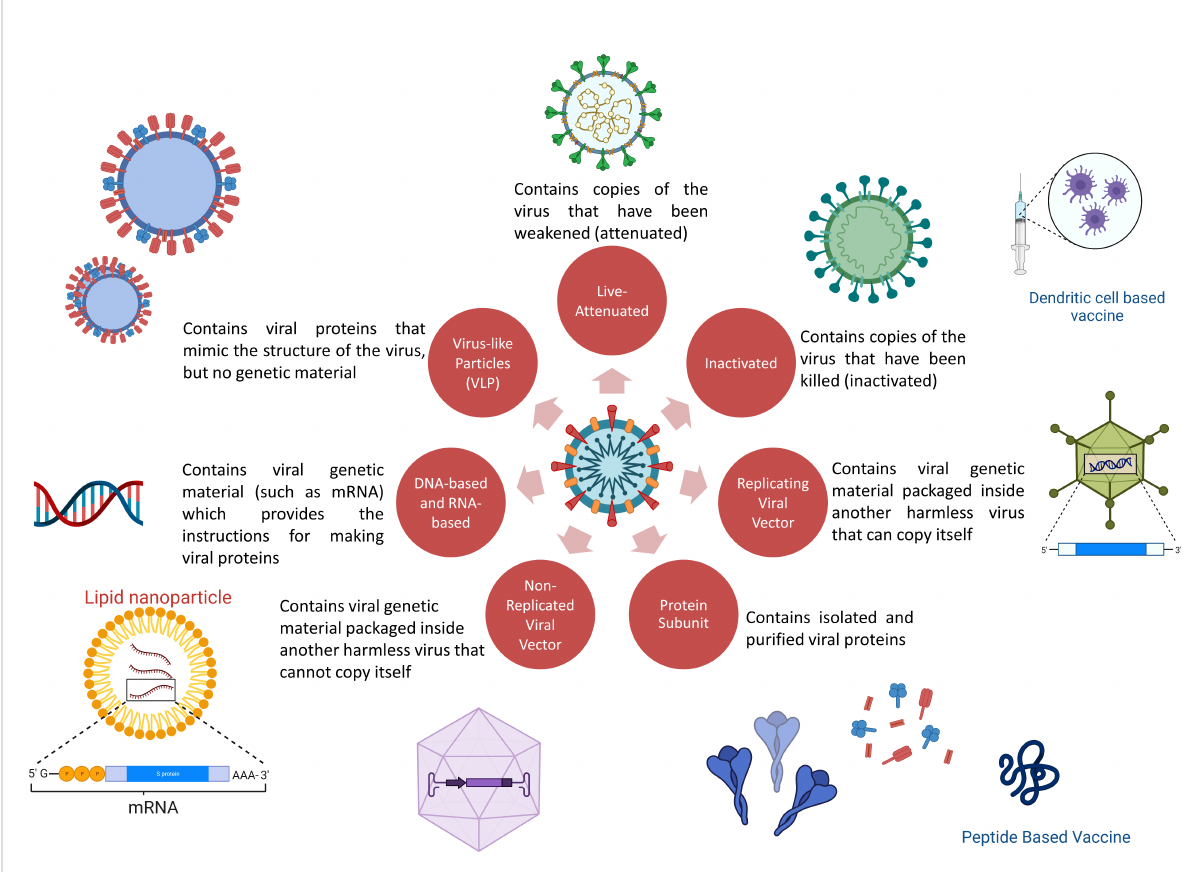
FIGURE 3 Hybrid variants of SARS-CoV-2 (Created with